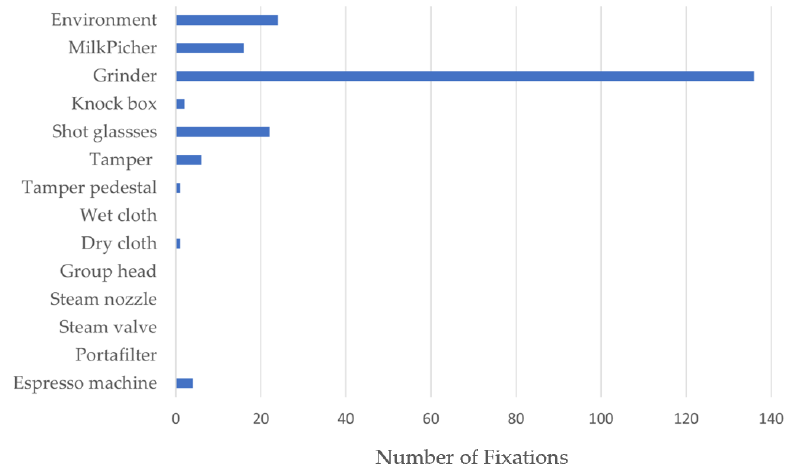
Figure 12. Example of the number of fixations on each object: Terminology education, step 1, fail.